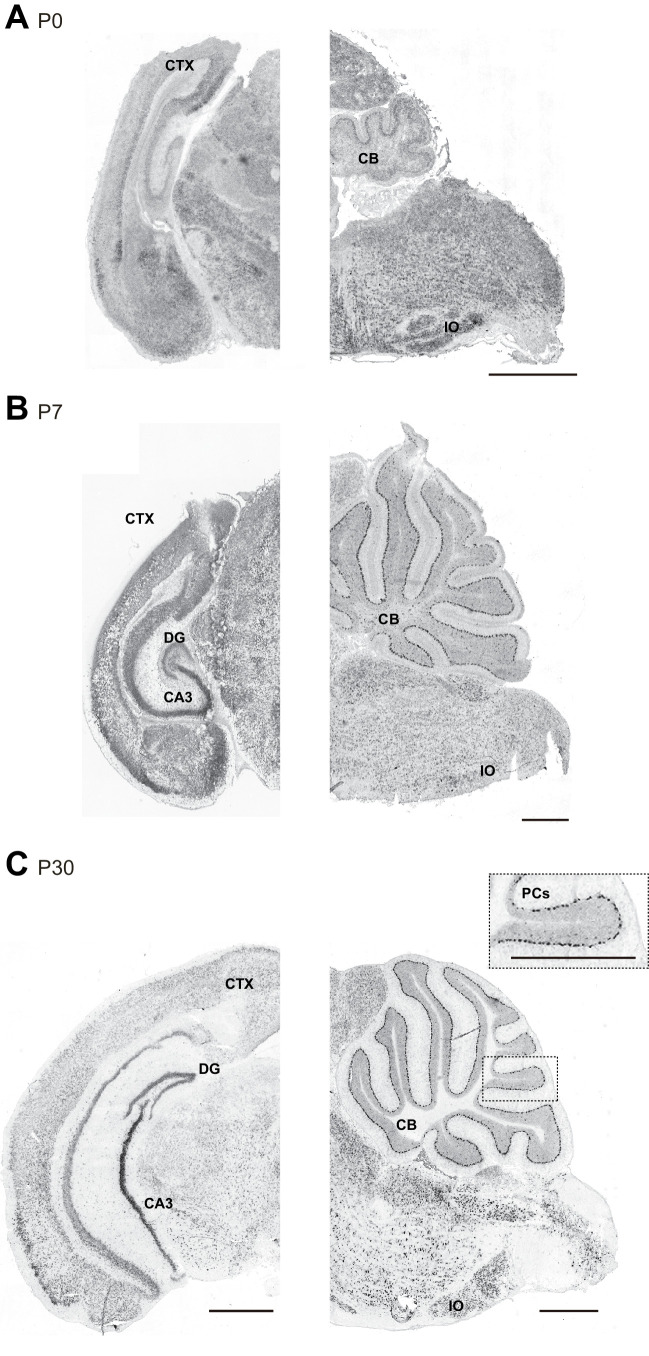
Susd4 mRNA expression in the developing mouse brain.(A) Susd4 mRNA expression was visualized in the brain of wild-type mice by in situ hybridization. Coronal (left) and sagittal (right) sections are presented at postnatal day 0 (P0), (B) postnatal day 7 (P7), and (C) postnatal day 30 (P30). Susd4 expression was found in many regions including the cerebral cortex (CTX), the dentate gyrus (DG) and CA3 regions in the hippocampus (coronal section, left), the cerebellum (CB), in particular Purkinje cells (PCs), and the inferior olive (IO; sagittal section, right). Scale bars 250 and 500 μm (inset C).